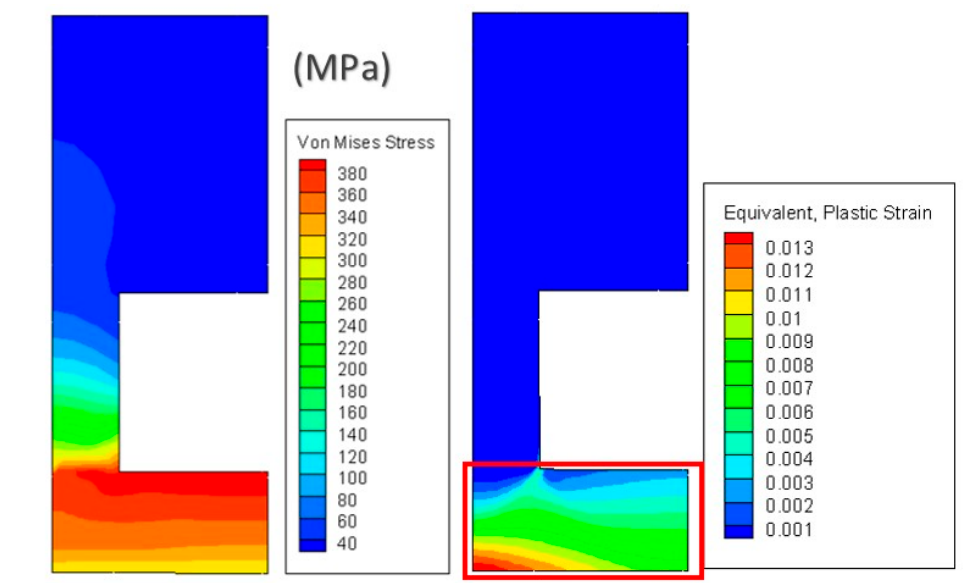
Figure 10. Von Mises stress (left) and Equivalent plastic strain (right) contour plots—Reference Model.